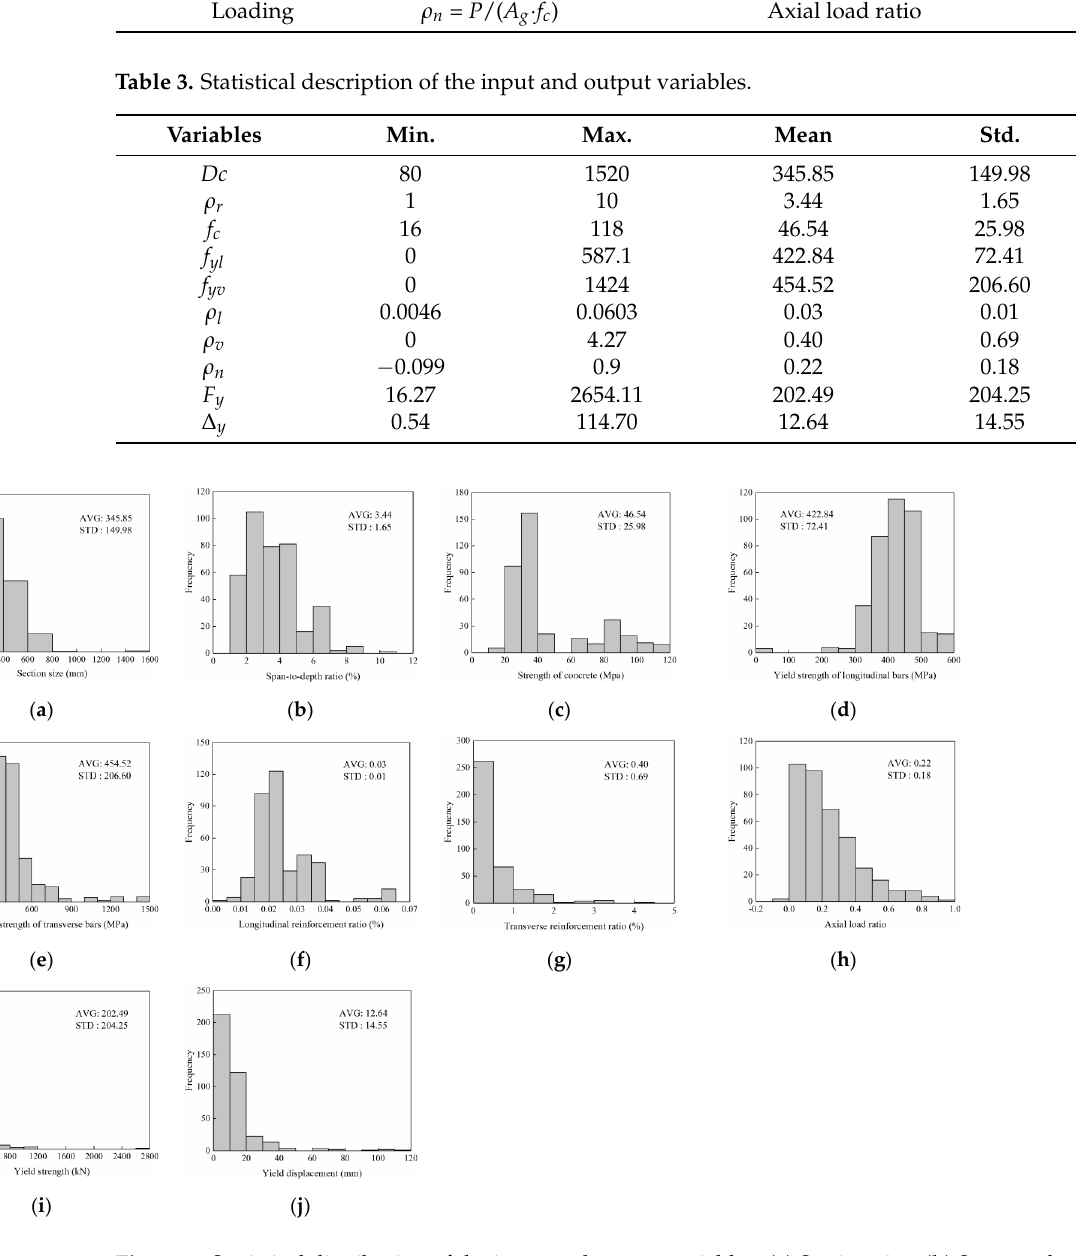
Figure 3. Statistical distribution of the input and output variables. ( a ) Section size; ( b ) Span-to-depth ratio; ( c ) Strength of concrete ; ( d ) Yield strength of longitudinal bars ; ( e ) Yield strength of transverse bars ; ( f ) Longitudinal reinforcement ratio ; ( g ) Transverse reinforcement ratio ; ( h ) Axial load ratio ; ( i ) Yield strength ; ( j ) Yield displacement .